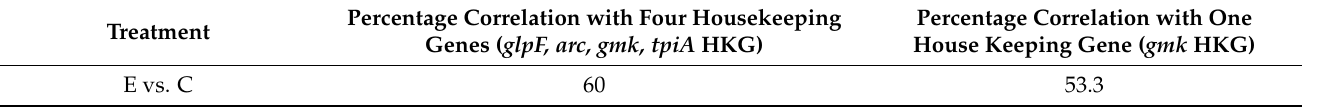
Table 5. RT-qPCR percentage of correlation with microarray